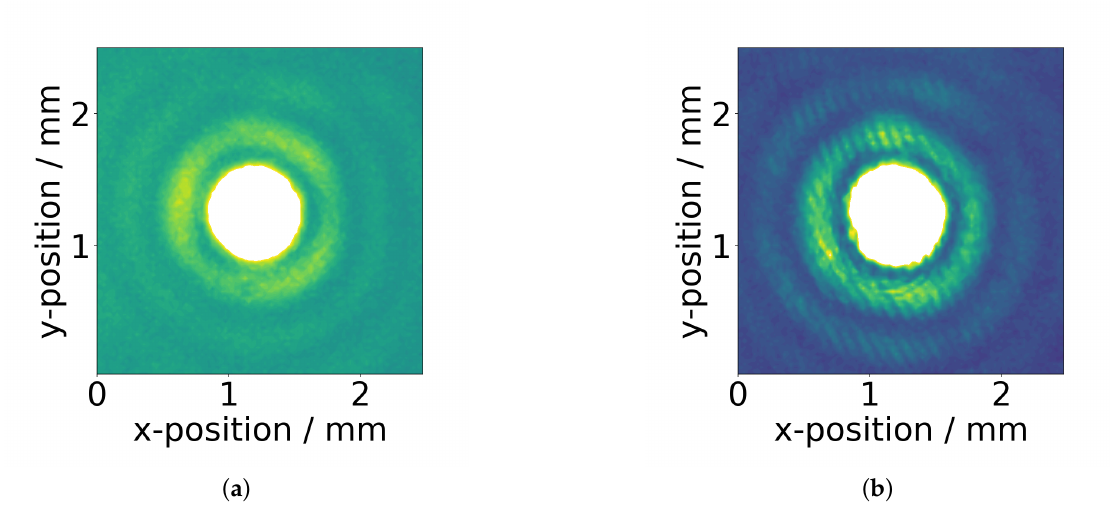
Figure 3. Si 3 N 4 sample surface imaged during nanostructuring by the back reflection diagnostic. ( a ) first pulse, ( b ) back reflection after the structure has been formed. Scales refer to the image plane. Magnification factor: M = 10 ×